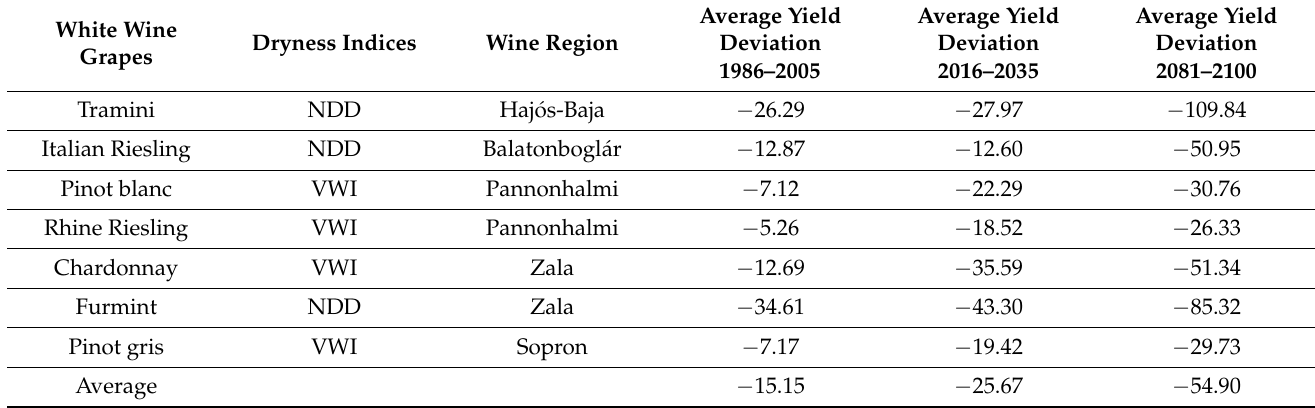
Table 9. Average estimated deviations of white wine grape yield (q/ha) from the agricultural trends produced based on the regression coefficients of the best quadratic fits of dryness indices in the different 20-year periods. The deviations for which the t-test indicated significant differences are set in italics (five such pairs are found, each one for the distant future).